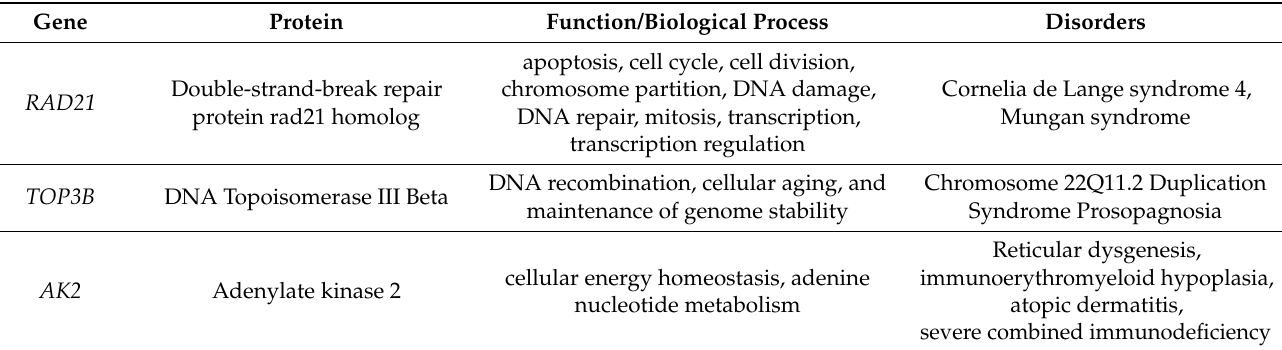
Table 3. Genes and proteins involved in the pathogenesis of various diseases, the expression of which is regulated by the AEDG